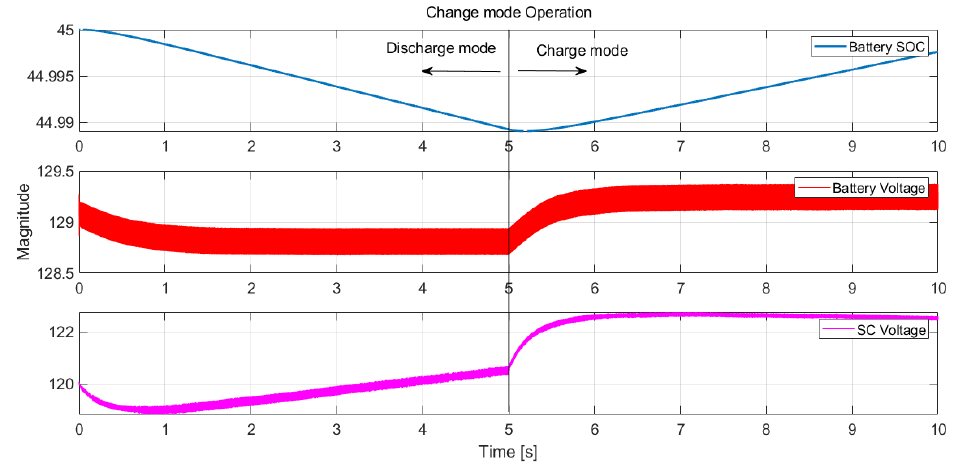
Figure 15. Battery and SC